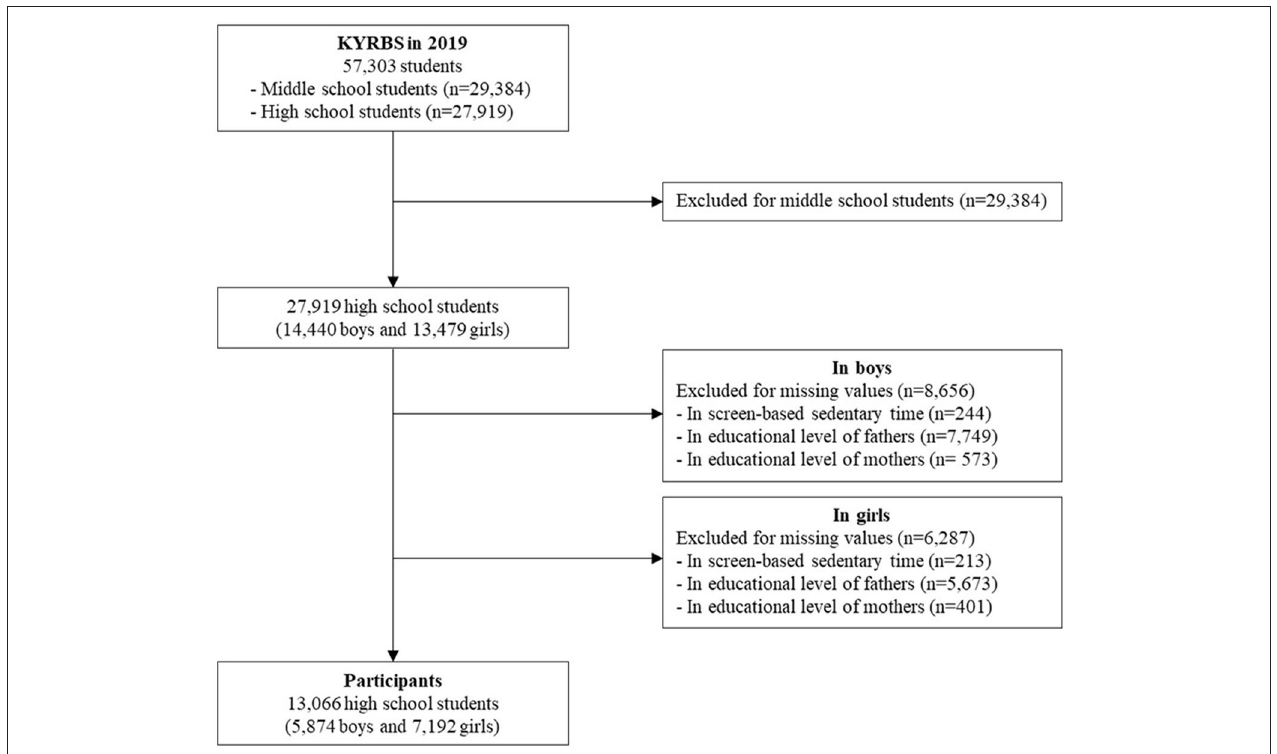
FIGURE 1 | Sampling process. KYRBS, Korea Youth Risk Behavior Web-based Survey.